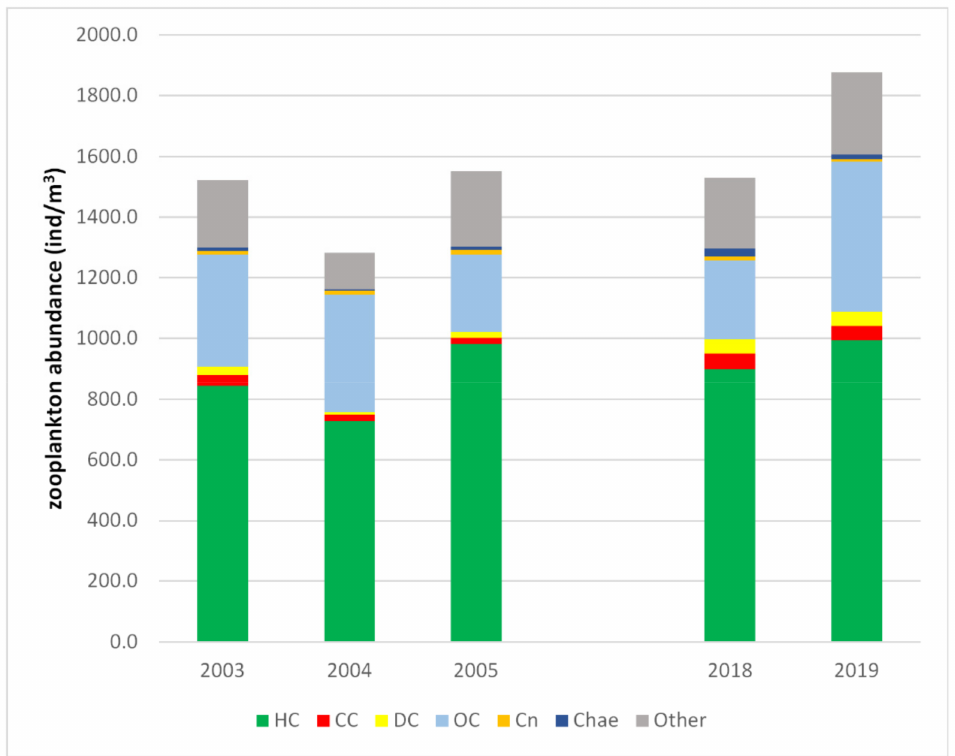
Figure 4. Zooplankton average abundance (ind/m 3 ) in the five years according to main taxa (Cope- pods are divided by trophic strategy: HC-herbivorous copepods, CC-carnivorous copepods, DC- detritivorous copepods, OC omnivorous copepods; Cn-Cnidarians; Chae-Chaetognata; Other- other organisms mainly Cladocera, Appendicularia, Thaliacea and